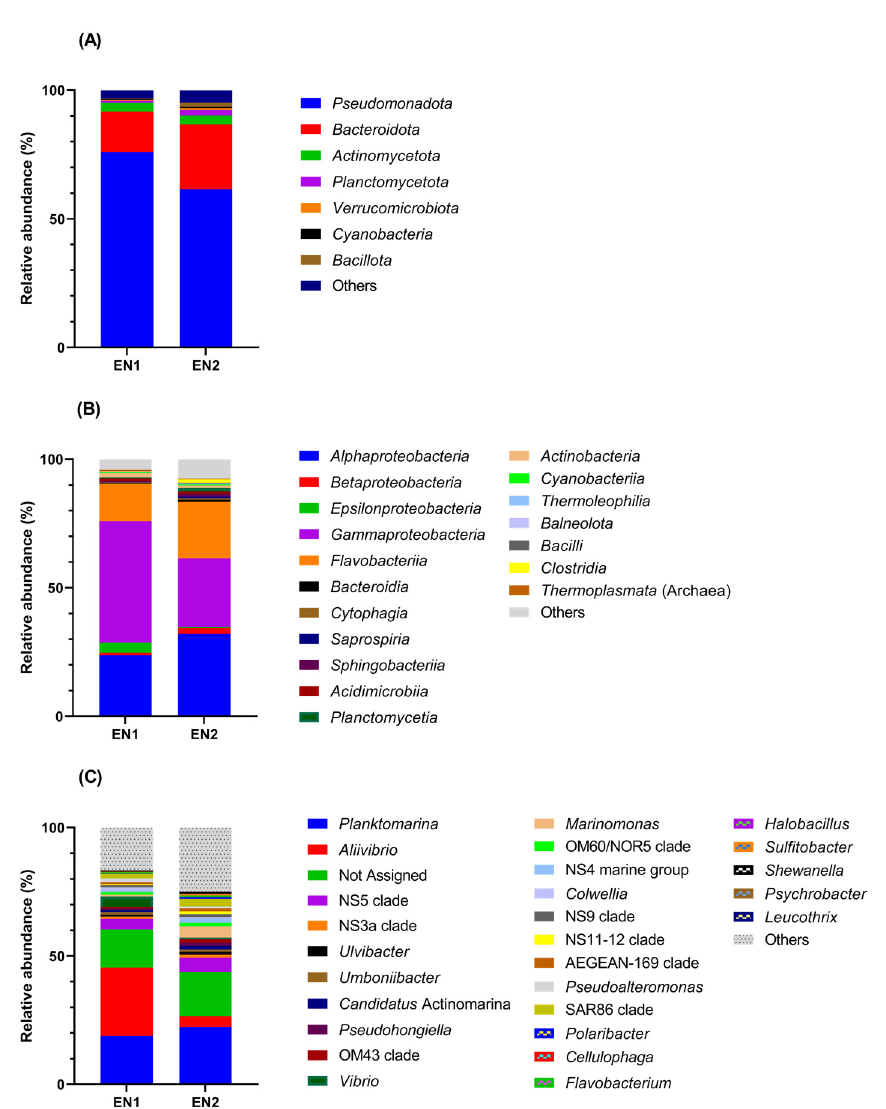
Figure 3. Community structure of uncultured bacteria from EN Black Sea sites. Relative abundances of the taxa at phylum ( A ), class ( B ), and genus ( C ) levels were determined as indicated in Methods.